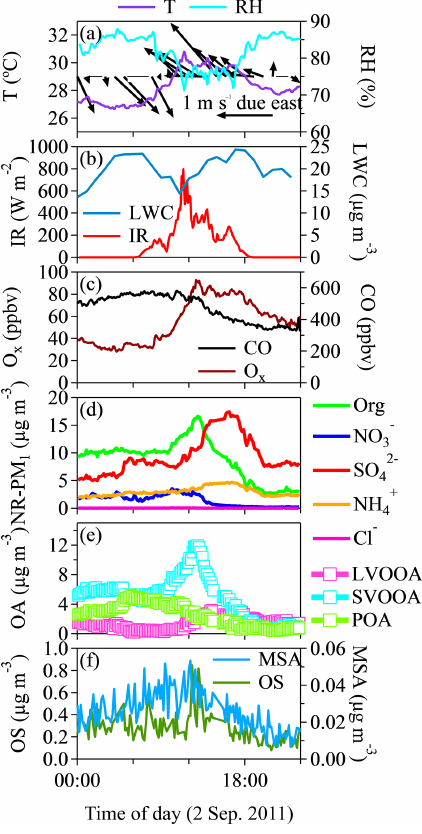
Figure 7. Time series of meteorological parameters, gaseous species, NR-PM 1 species and PMF-resolved organic factors in E4. merous constituents from different primary sources and re- action products formed via different atmospheric processes.